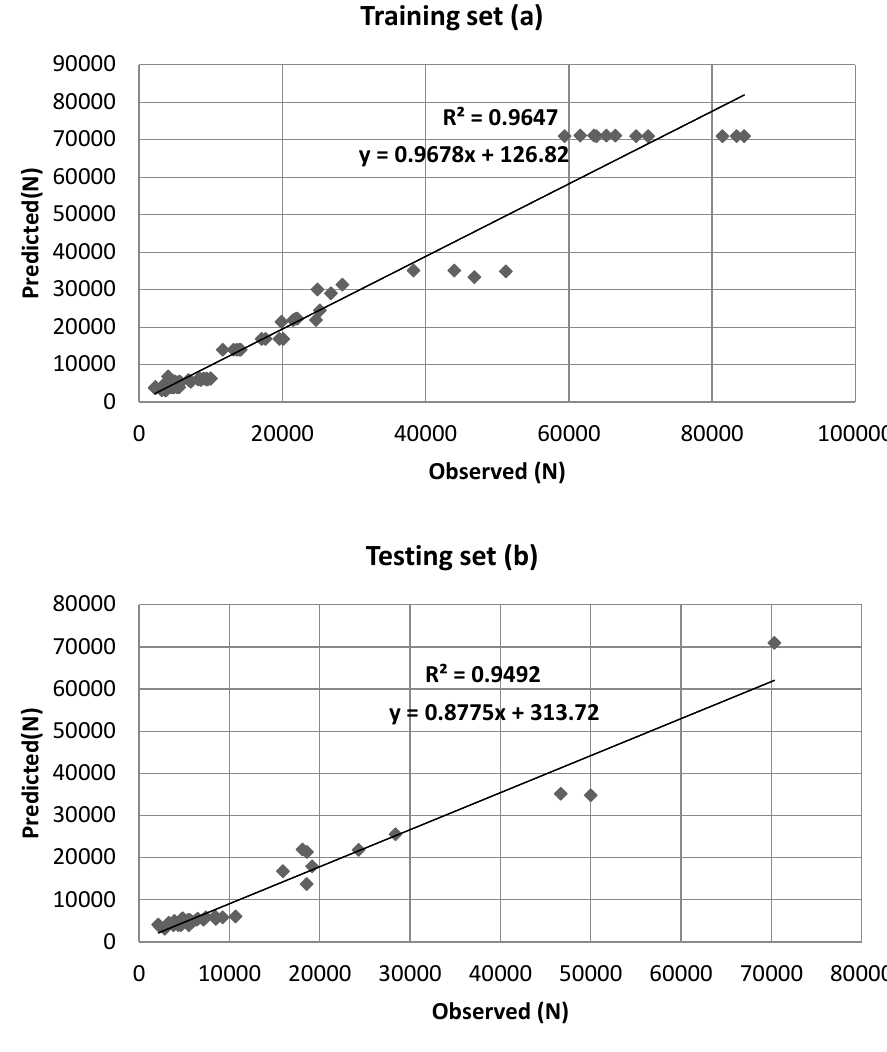
Figure 3. Observed and predicted debonding forces by GEP for ( a ) training and ( b ) testing data. Table 4. General parameters of the applied GEP (gene expression programming)